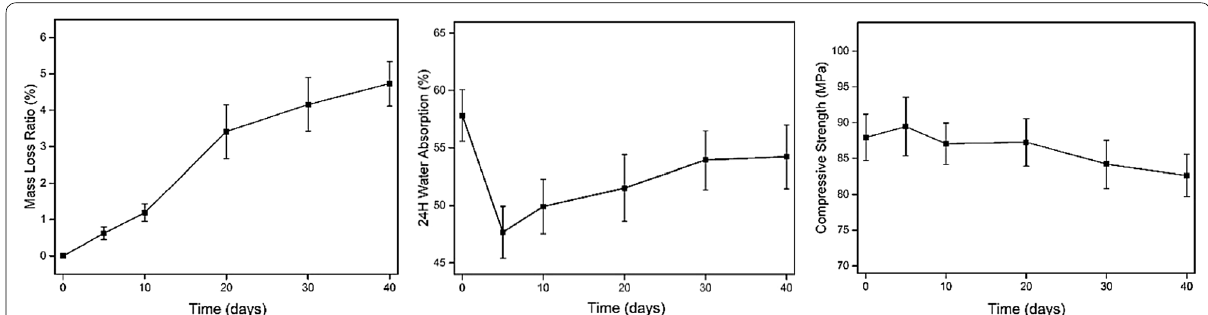
Fig. 6 Effect of fungi pigment on mass loss ratio, 24-h water absorption, and compressive strength from 0 to 40 days. The results represent the mean SD ( n ± =